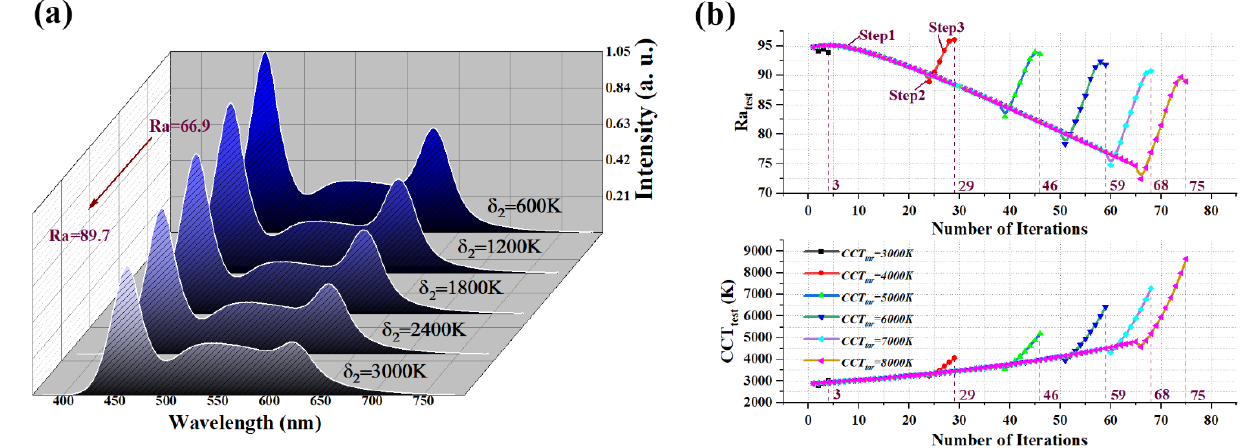
Figure 5. ( a ) The optimized spectra of the trichromatic WLED under the condition of CCT tar of 8000 K and δ 1 of 200 K. ( δ 2 is ranging from 600–3000 K); ( b ) the shifting trend of iterations of CCT test and Ra test under different CCT tar values.